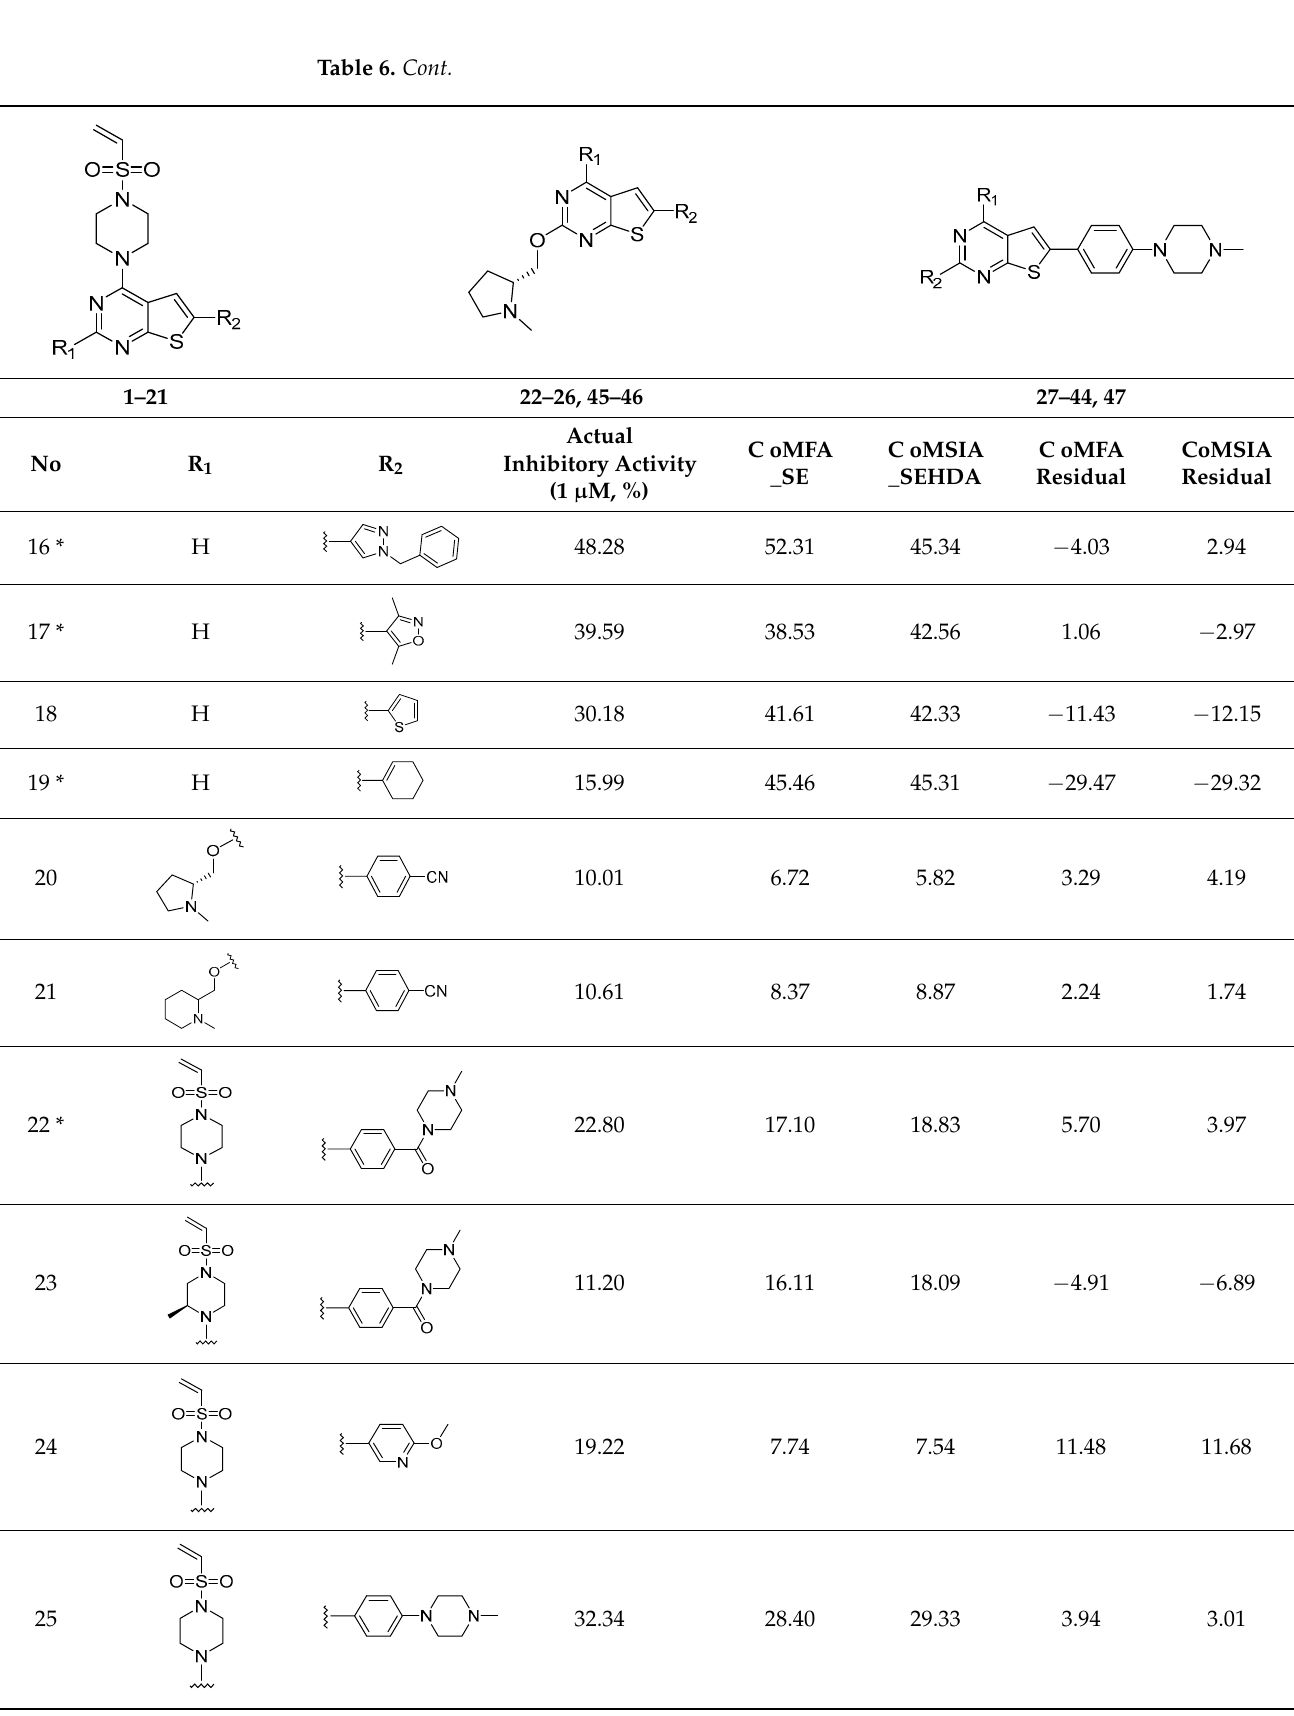
Table 6. Chemical structures and inhibitory activity values of thieno-pyrimidine derivatives. Table 6. Cont.